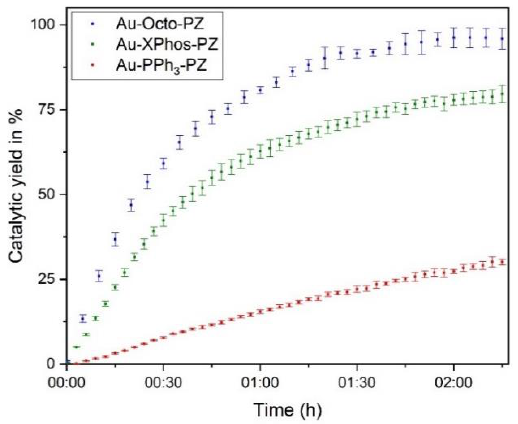
Figure 4. Kinetic behavior of the PZs toward the cyclization of the coumarin derivative, showing enhanced activity of Au-Octo-PZ polyzyme. The experiment was performed in triplicate. The error bars represent the standard deviation of all respective measurements.